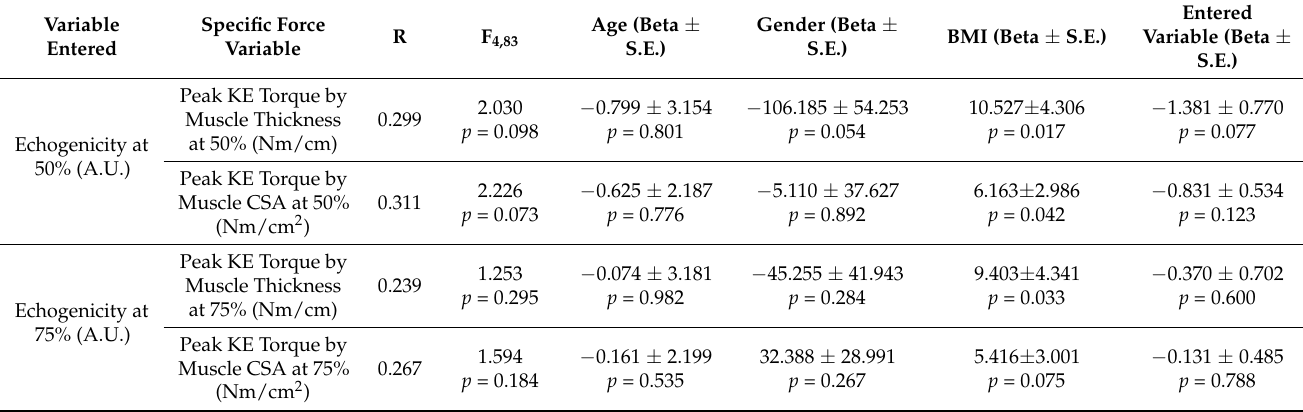
Table 4. Association of echogenicity assessed via ultrasonography captured using the panoramic feature and B-mode images of the right leg with various assessments of knee extensor specific force in 88 middle-aged men and